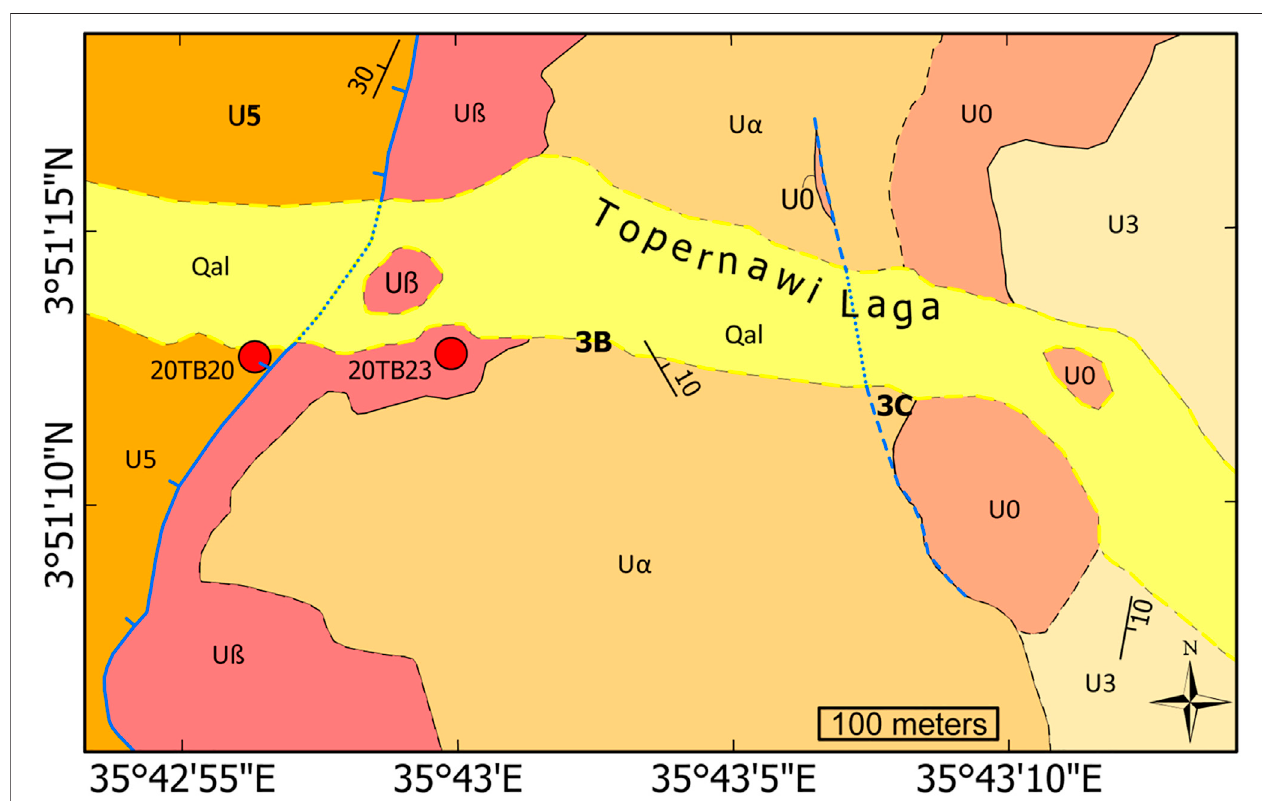
FIGURE 4 | Geologic map of the portion of the Topernawi Formation where the newly discovered units outcrop and new geochronology samples were taken (extentshown on Figure 1 ).Qal is Quaternary alluvium of Topernawi Laga. Contacts areshown assolidwhere well located, dashed where approximated, dotted where concealed. Faults are inblue, depositional contacts are in black. Bedding attitude measurements are shown as strike and dip symbolwith dip angle adjacentto symbol. Large red circles show location of new geochronology samples. Location of photo in Figure 3A is at 20TB23. Location of photo in Figure 3B is labeled in black lettering as 3B. Location of photo is Figure 3C is shown in black lettering as